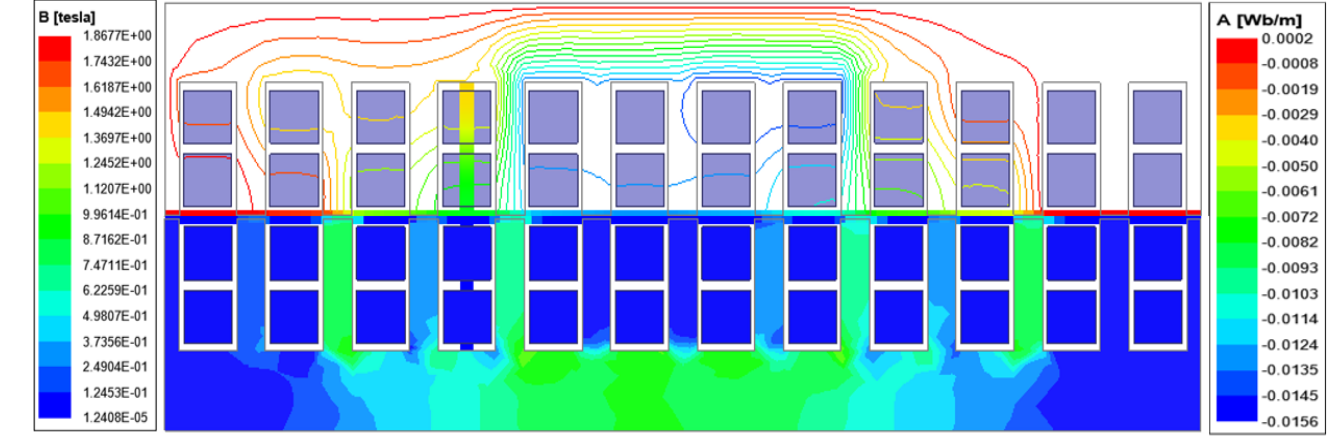
Figure 12. The 2D FEM simulation model.